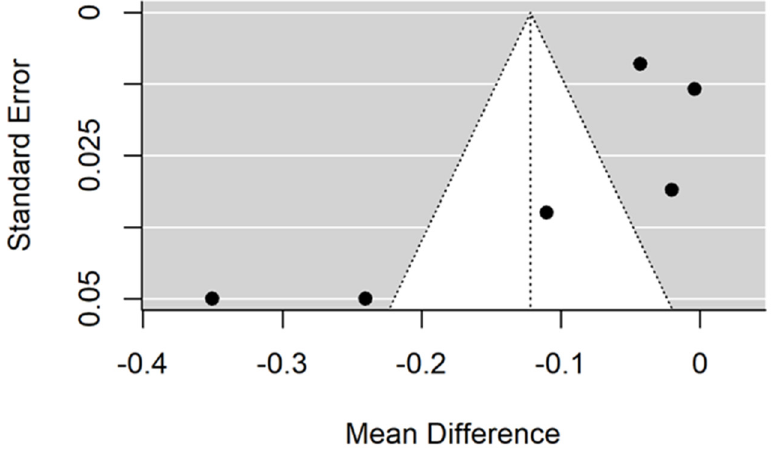
Figure 11. Forest plot for evalutaion of thread shape factor influence on pull-out strentght in artifical bone model studies.